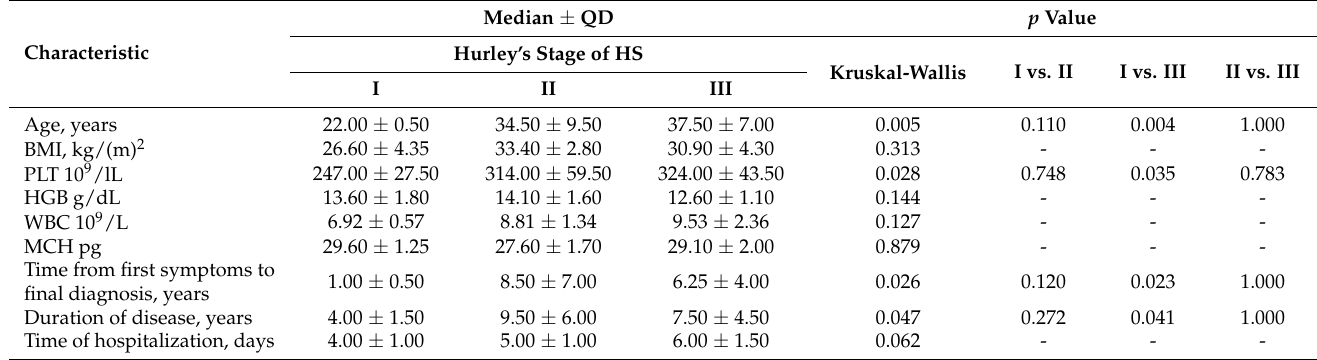
Table 3. Clinical characteristics of patients with HS with regard to Hurley’s stage of Hidradenitis suppurativa.